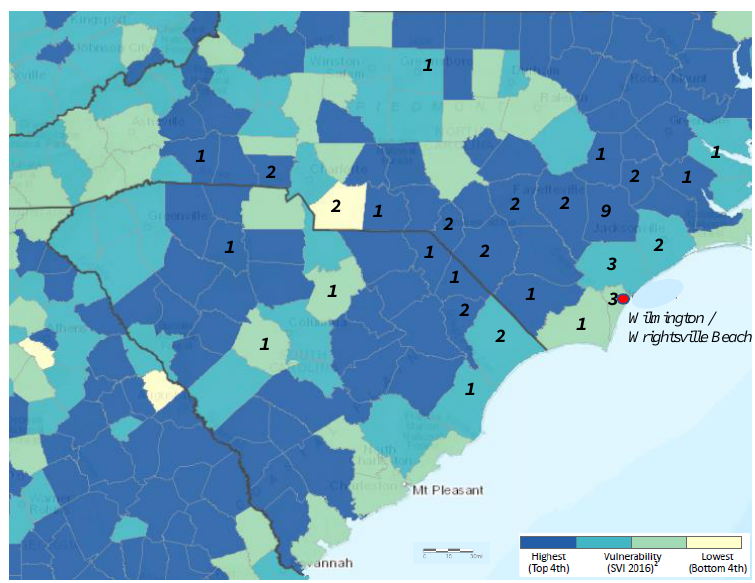
Figure 2. Hurricane Florence Fatalities per County Social Vulnerability in North and South Carolina. Figure 5 – Hurricane Florence fatalities overlaid on social vulnerability by county